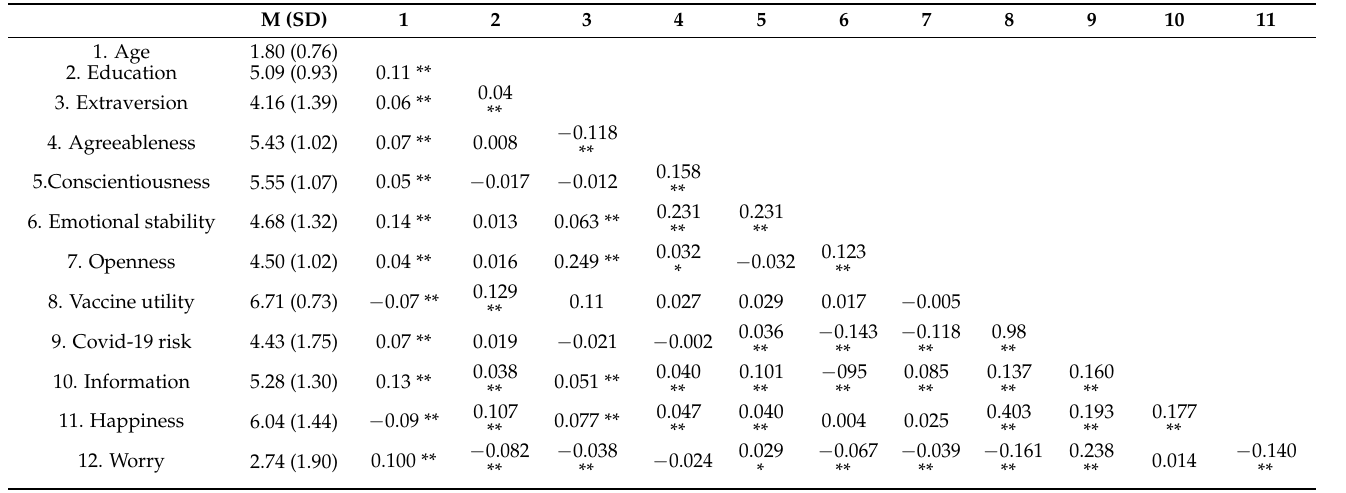
Table A3. Descriptive statistics of study variables: means, associated standard deviations and Pearson’s r bivariate